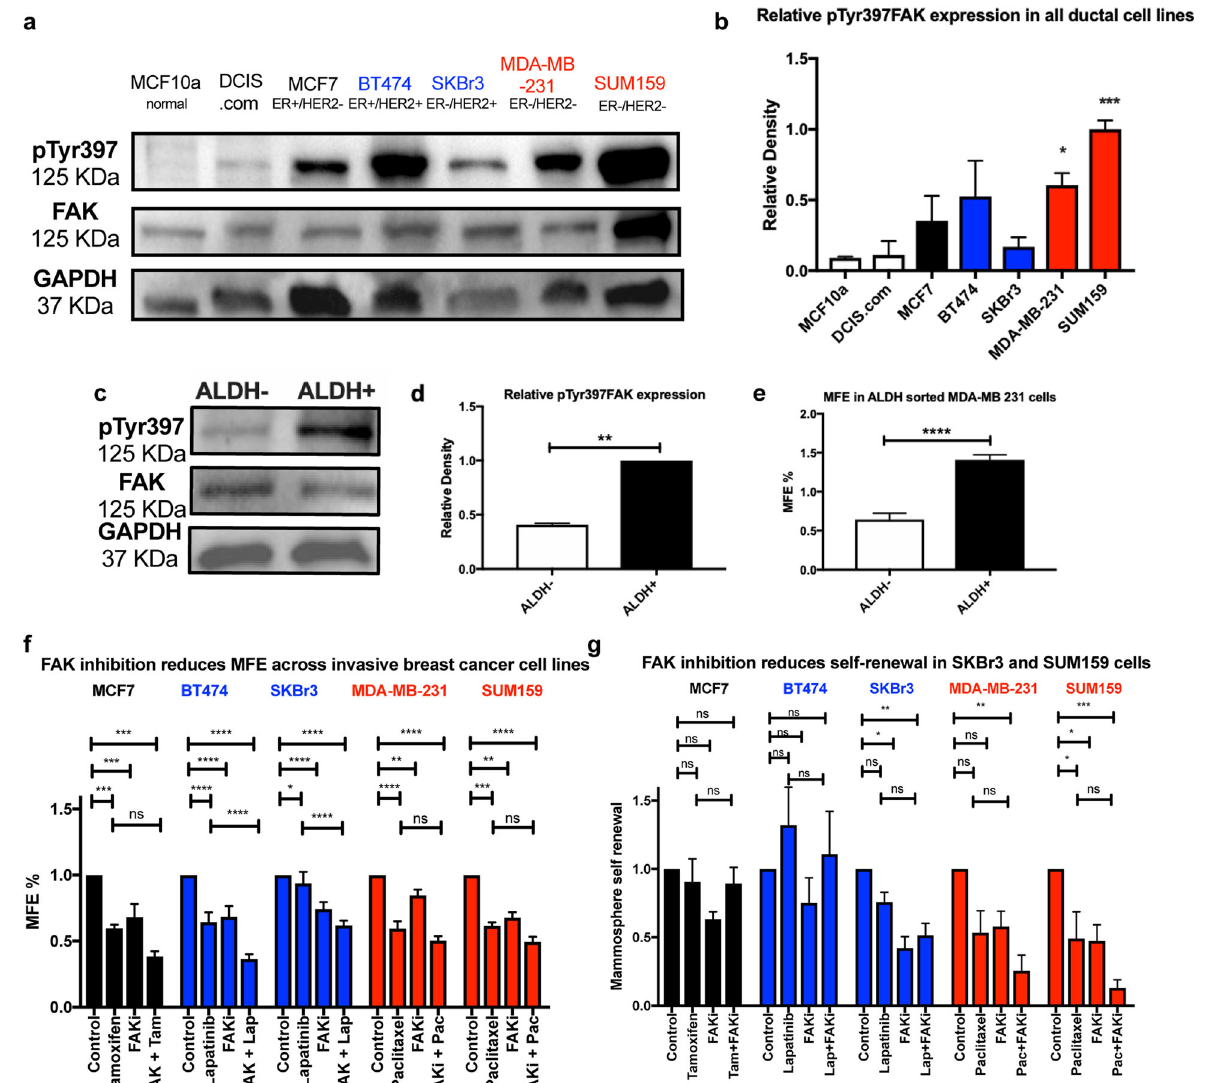
Fig. 1 pTyr397FAK expression is higher in triple negative cell lines and ALDH + cells. FAK inhibition in combination with adjuvant therapies reduces CSC activity. a Representative Western blot demonstrating baseline expression of pTyr397FAK, FAK, and GAPDH in breast cell lines including invasive carcinoma cell lines re fl ecting all molecular phenotypes. b Illustrative plot of relative density of pTyr397FAK to FAK, with relative density of pTyr397FAK to FAK measured and corrected for GAPDH. pTyr397FAK expression in normal ductal cell line MCF10a used as comparison. One-way ANOVA with post hoc Dunnett ’ s test ( n = 2 for MCF10a and DCIS.com and n = 3 for IDC cell lines). c Representative Western blot demonstrating pTyr397FAK expression in ALDH + and ALDH − MDA-MB-231 cells with illustrative plot of relative densities shown in ( d ) ( n = 3). e ALDH + cells have increased primary MFE compared to ALDH − expressing cells. Both D&E analysed using unpaired two tailed t - test. f FAK inhibition with VS4718 0.5 μ M reduced primary MFE as a single agent therapy across all cell lines. This was evaluated alongside 1 μ